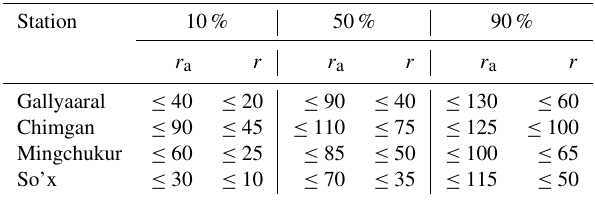
Table 3. Threshold probabilities (10%, 50% and 90%) inducing mudflow events at four stations (Gallyaaral, Chimgan, Mingchukur and So’x); r a – antecedent rainfall index (mm); r – daily rainfall value